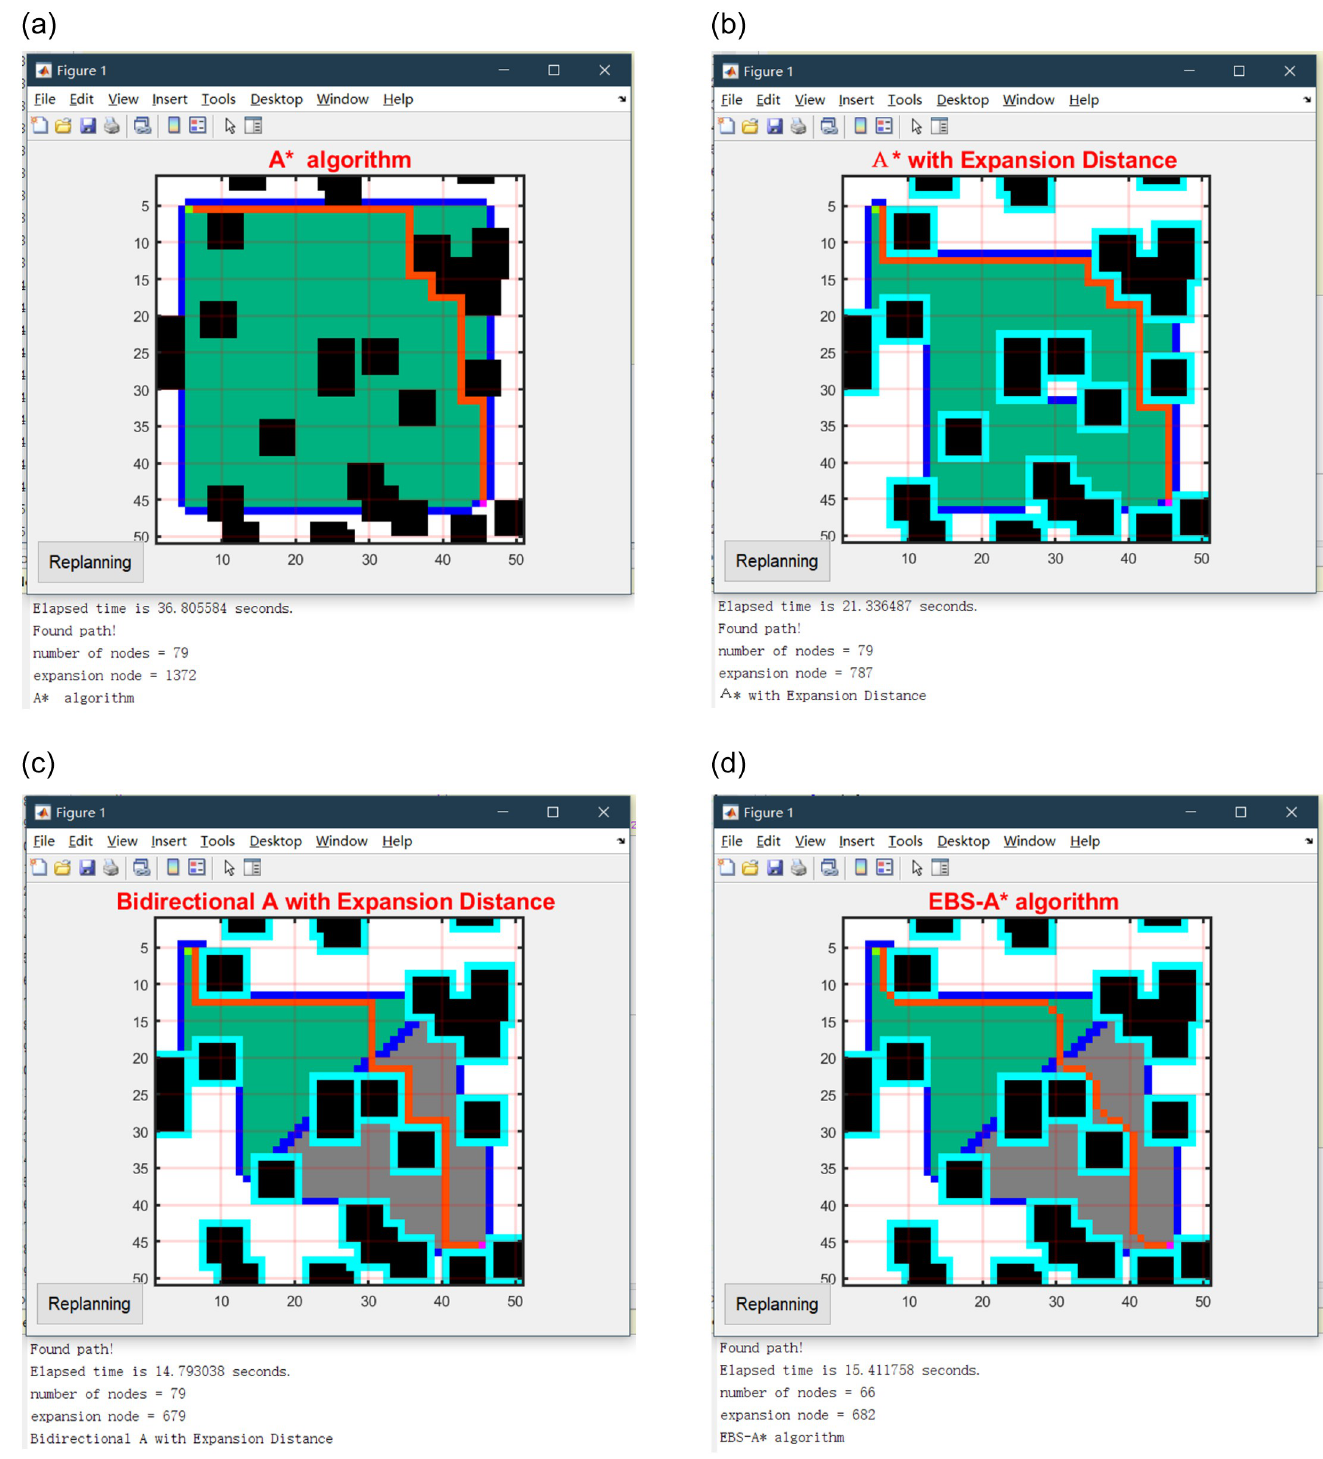
Fig 7. Simulation results of four algorithms on a 50 × 50 map. (a) A � algorithm. (b) A � with expansion distance. (c) Bidirectional A � with expansion distance. (d) EBS-A � algorithm.